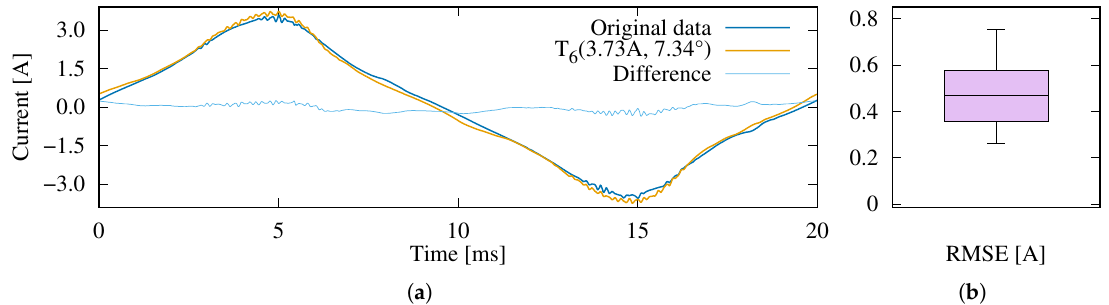
Figure 8. Example for the greedy heuristic to approximate the waveform of a planer appliance by means of parametric templates. ( a ) A single input cycle vs. its parameterized template representation; only a small difference exists between the two; ( b ) Distribution of RMSE